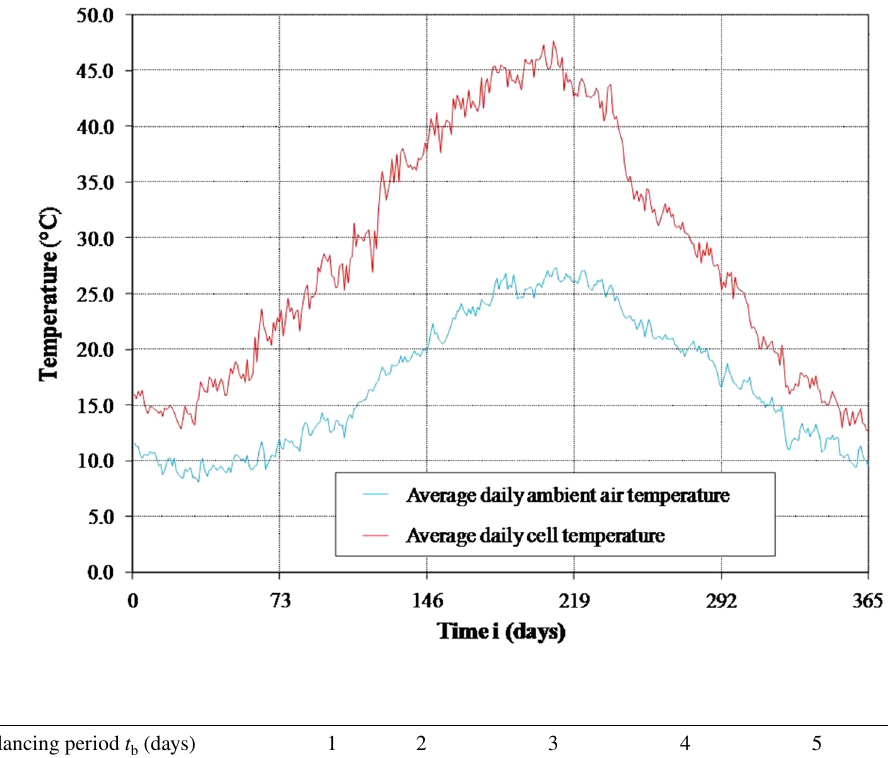
Fig. 7 Average daily cell temperature and average daily ambient air temperature